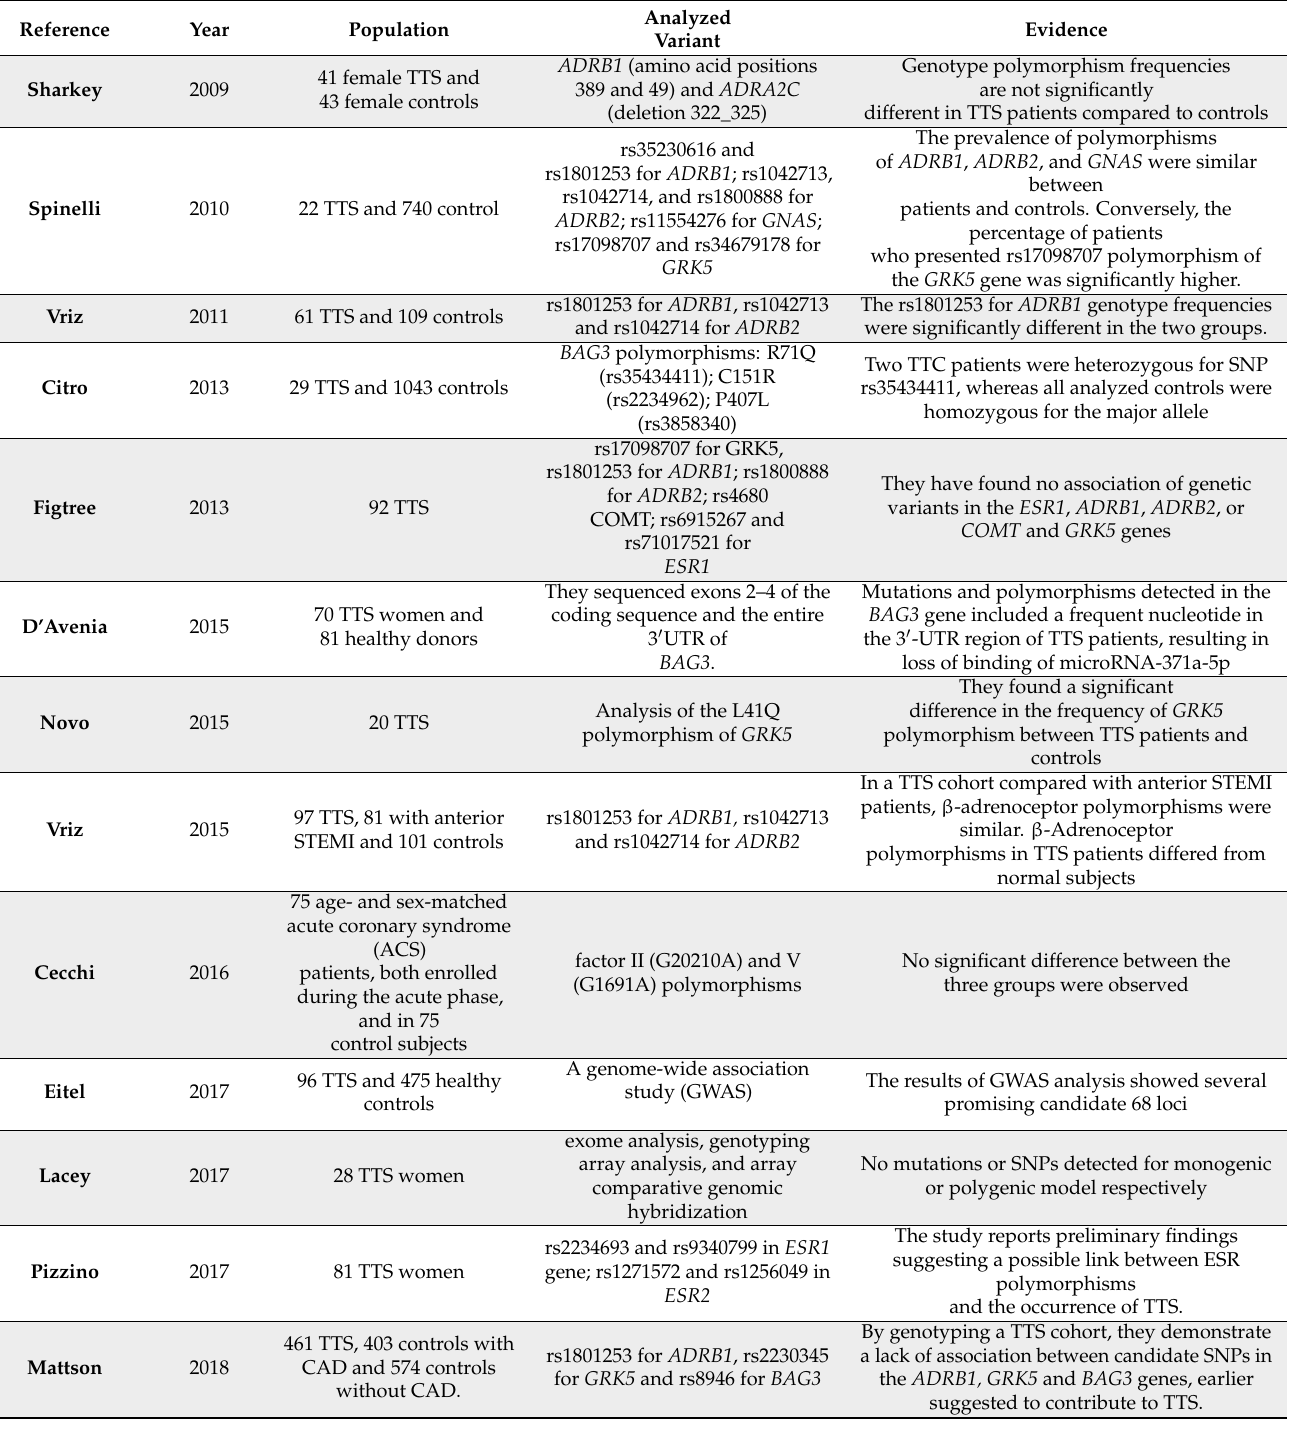
Table 2. Summary of polymorphisms found in patients affected by Takotsubo cardiomyopathy.